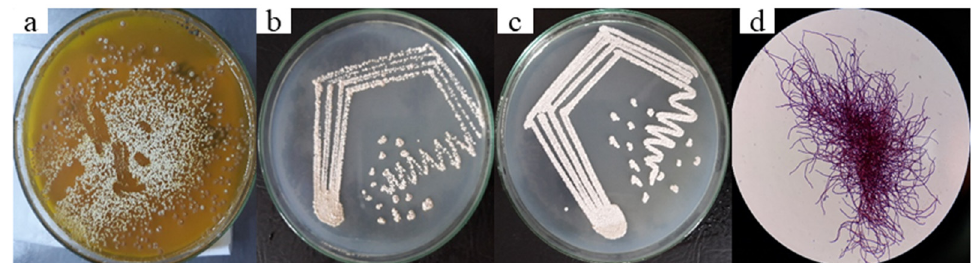
Figure 1. Morphological characterization; ( a ) Isolation plate; ( b ) Substrate mycelium; ( c ) Aerial mycelium; and ( d ) Gram staining of Streptomyces species SB10.